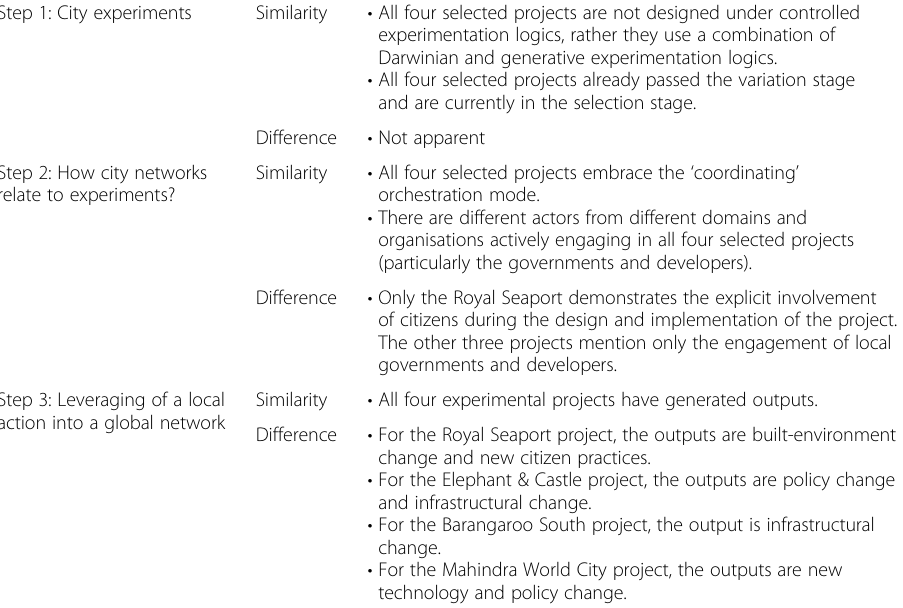
Table 4 Comparative analysis of four good practices against the proposed model Step 1: City